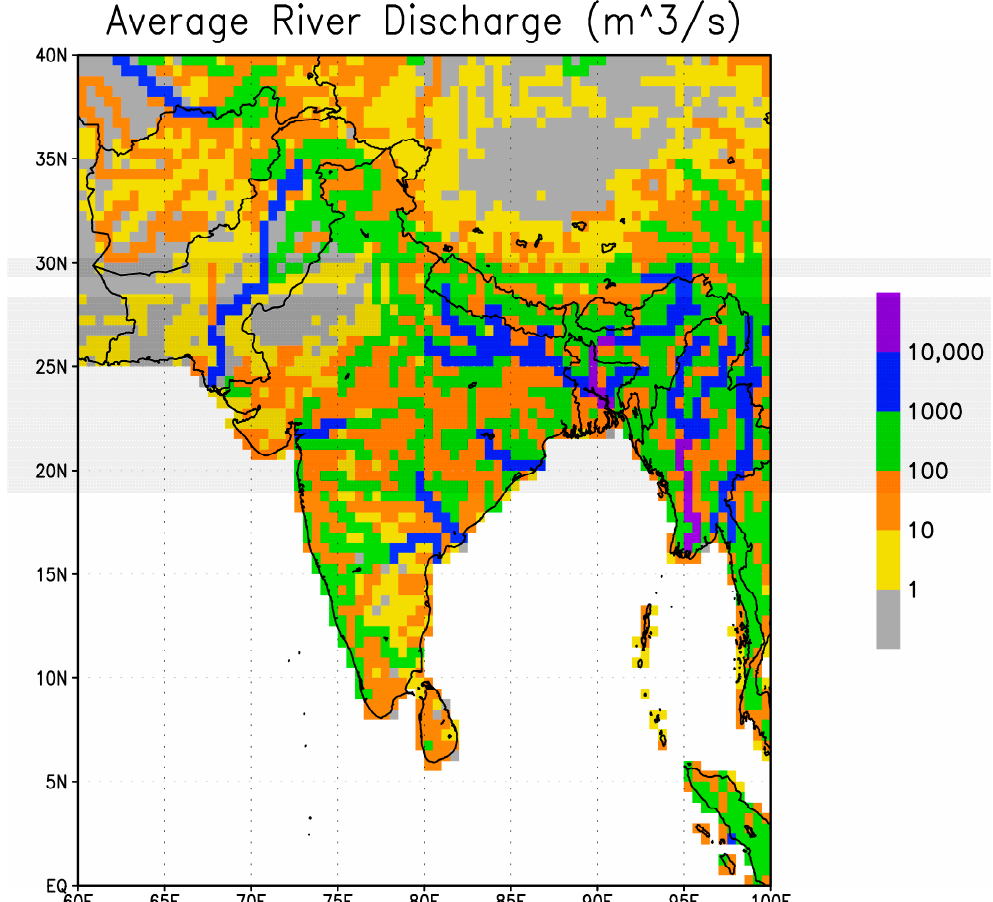
Figure 4. Mean river discharge (m 3 /s) from GloFAS simulation from 1980 to 2014.